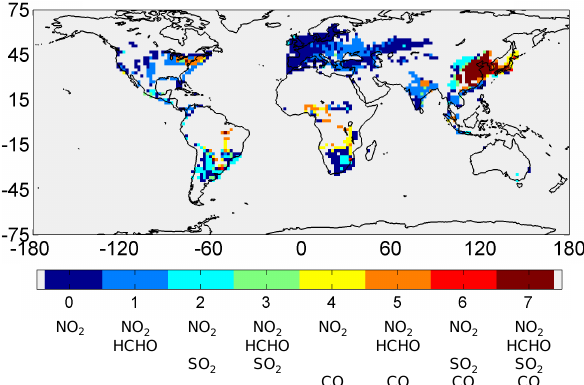
Figure 8. Trace gas composition for grid boxes with URB source for June–August 2007–2011. The presence of enhanced trace gas columns (in addition to NO 2 ) is indicated by 1, 2, or 4 for HCHO, SO 2 , and (cid:49) CO, respectively: 1 thus indicates enhanced NO 2 and HCHO, 2 enhanced NO 2 and SO 2 , 3 enhanced NO 2 and HCHO and SO 2 , etc. Gray areas are not dominated by URB.